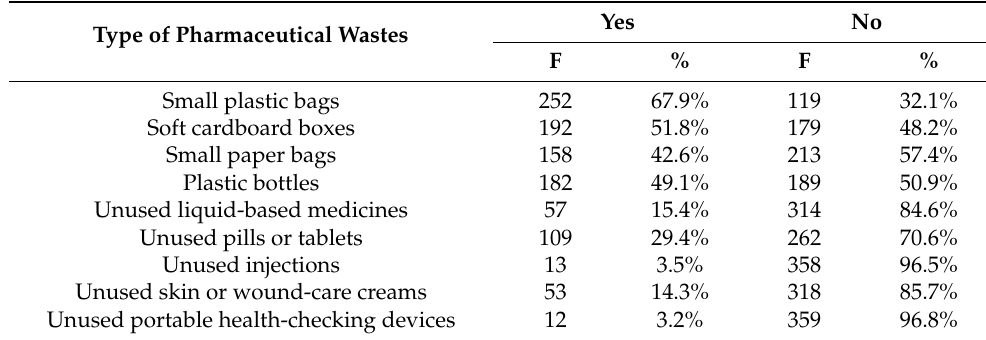
Table 2. Types of household pharmaceutical waste